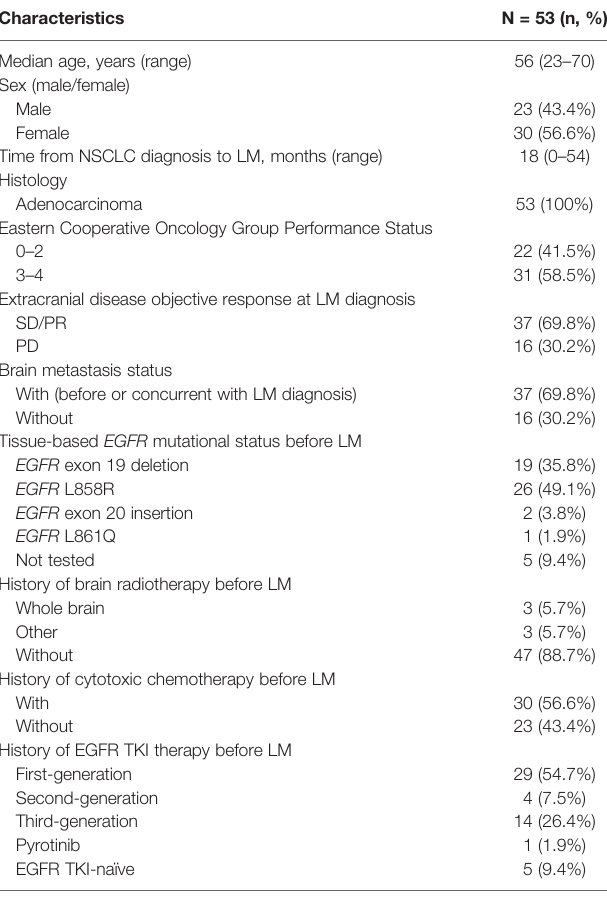
TABLE 1 | Clinical characteristics of patients with EGFR -mutated advanced non- small cell lung cancer (NSCLC) with leptomeningeal metastasis (LM) included in this